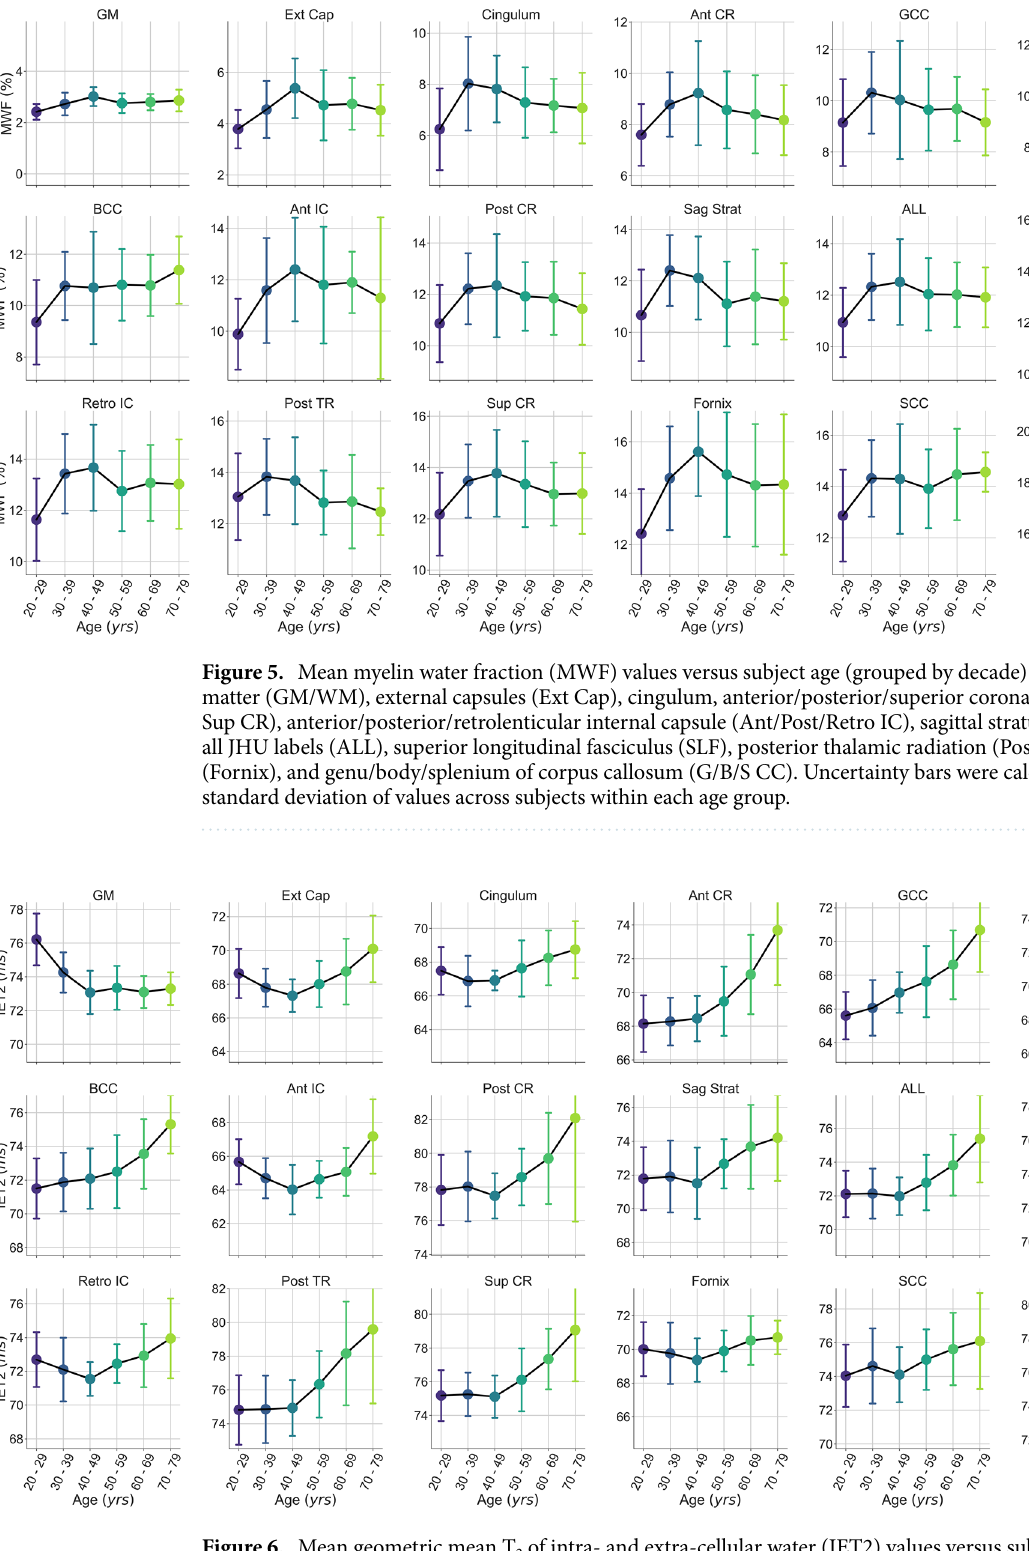
Figure 6. Mean geometric mean T 2 of intra- and extra-cellular water (IET2) values versus subject age (grouped by decade) within gray/white matter (GM/WM), external capsules (Ext Cap), cingulum, anterior/posterior/ superior corona radiata (Ant/Post/Sup CR), anterior/posterior/retrolenticular internal capsule (Ant/Post/Retro IC), sagittal stratum (Sag Strat), all JHU labels (ALL), superior longitudinal fasciculus (SLF), posterior thalamic radiation (Post TR), fornix (Fornix), and genu/body/splenium of corpus callosum (G/B/S CC). Uncertainty bars were calculated as the standard deviation of values across subjects within each age